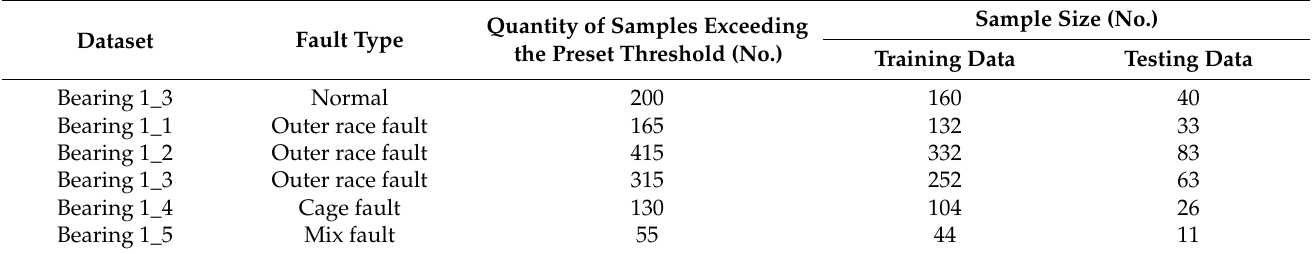
Table 5. Fault types and the sample size for training and testing data.